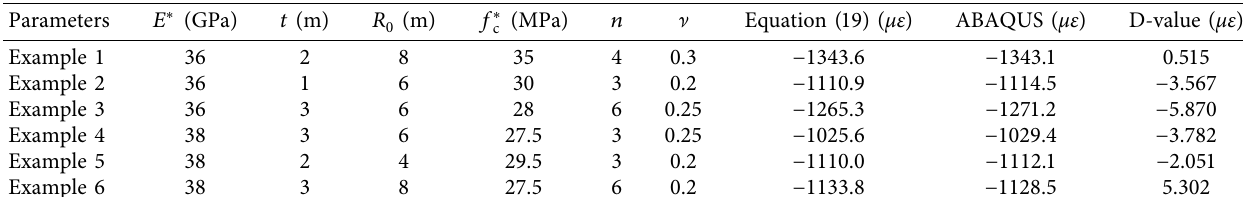
Table 3: Calculation results of maximum tangential strain of lining under random